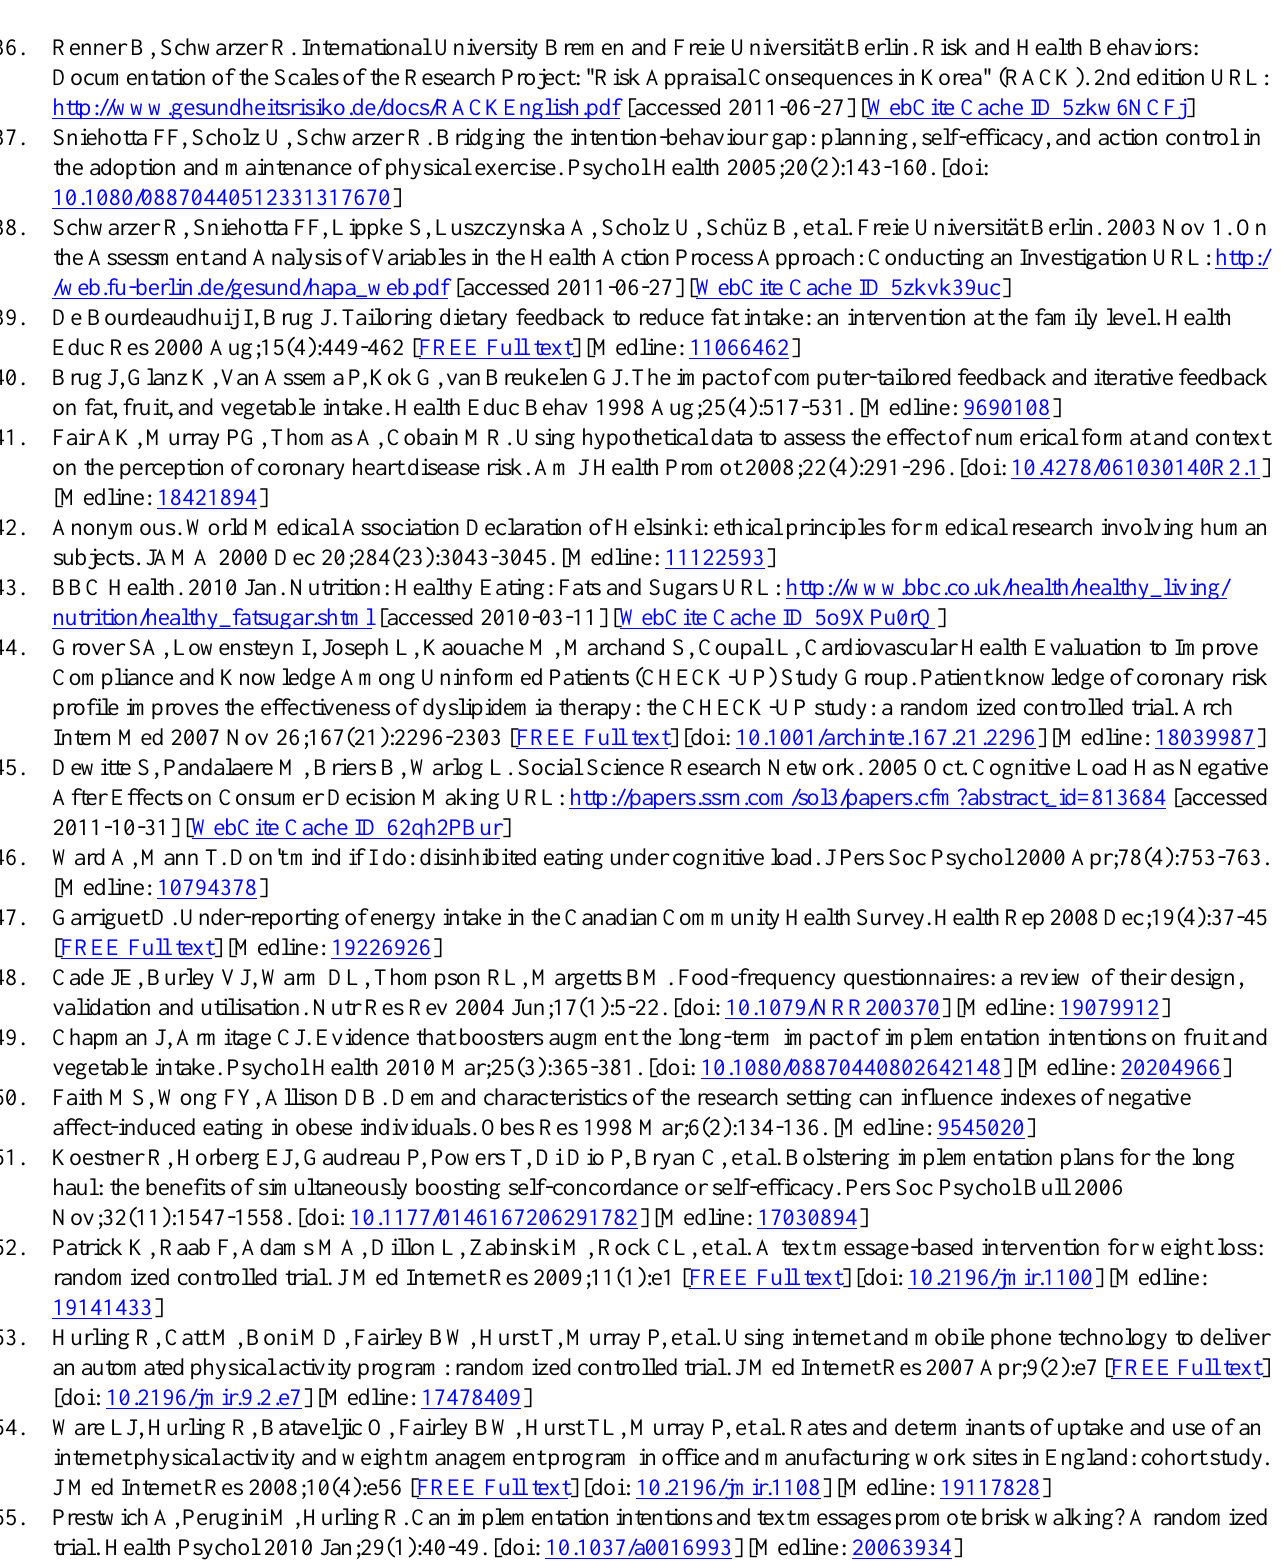
Abbreviations CG: control group CVD: cardiovascular disease FFQ: food frequency questionnaire HA: Heart-Age PT: planning